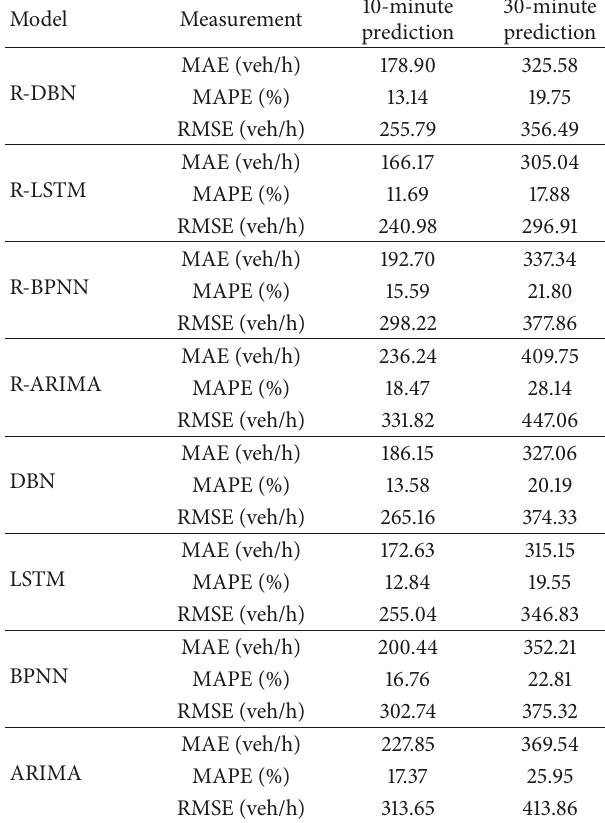
Table 2: Comparisons between different